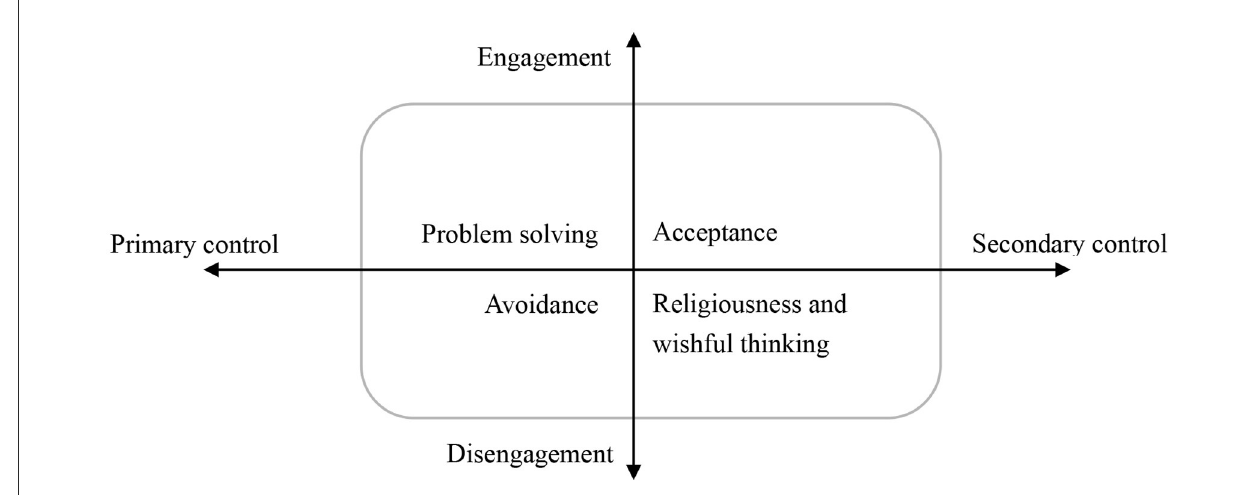
FIGURE4 Categories of coping strategies for women with a fetal anomaly.